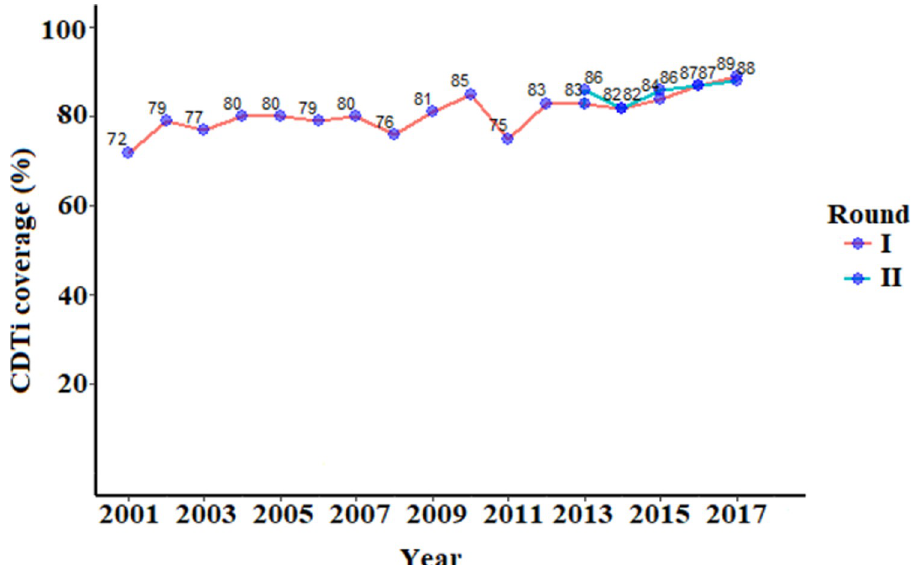
Fig 2. Trend of CDTi coverage rate in Yeki district of SNNPR, southwest Ethiopia (2001–2017). (Source: Yeki district health office). https://doi.org/10.1371/journal.pone.0263625.g002 detected in 58(3.4%; 95% CI: 2.3–5.7%) and 18(3.7%; 95% CI: 2.3–5.7%), respectively (Table 2). Results of multivariate logistic regression analysis showed that study participants aged 5–9 years had a significantly higher prevalence of A . lumbricoides (Adjusted odds ratio (AOR) 6.5, 95% CI 1.7–25.4, p = 0.007), T . trichuria (AOR 8, 95% CI 2.6–25.1, p < 0.001), and any STH larly, a significantly higher prevalence of T . trichuria infection was observed in individuals in